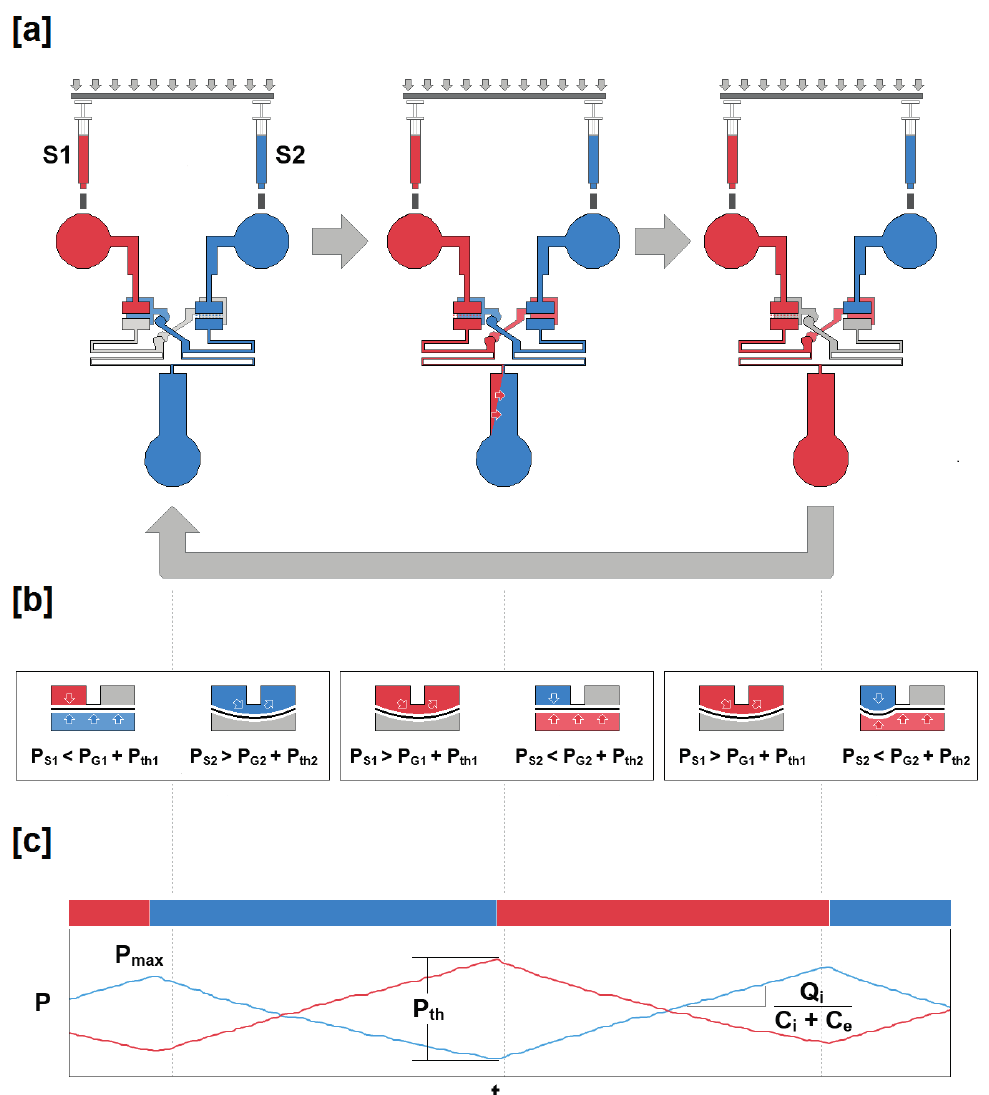
Figure 1. Schematic for the experimental system. The three panels displayed represent the behavior of the microfluidic oscillator at three time points during operation under symmetric flow conditions. ( a ) Two fluids (blue and red) are introduced through two syringes mounted on a single syringe pump. The fluids enter the device at a constant rate, but are converted into an oscillatory outflow when passing through the valves. ( b ) A cross section of each valve unit at the time points displayed in panel ( a ). Initially, the source pressure ( P S 1 ) is insufficient ( P S 1 < P G 1 + P th 1 ) to displace the membrane downward, allowing the blue fluid to outflow. When the pressure has reached its maximum value ( P max ), the membrane is displaced ( P S 1 > P G 1 + P th 1 ), allowing the red fluid to outflow until sufficient source pressure ( P S 2 ) has accumulated within the chamber above the opposite membrane ( P S 2 > P G 2 + P th 2 ) allowing the blue fluid to outflow. ( c ) The time points within the pressure data time series corresponding to the valve and outflow profiles presented in panels ( a ) and ( b ) are indicated. A sample P max and P th are also represented, as well as the relationship between inflow rate ( Q i ), internal capacitance ( C i ), and external capacitance ( C e